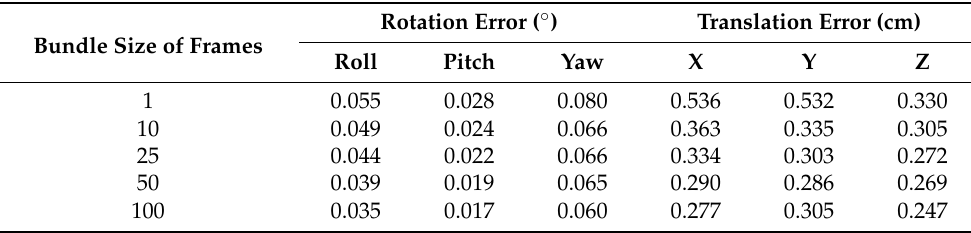
Table 9. Comparison of calibration performance according to the bundle size of frame for temporal filtering on the Oxford